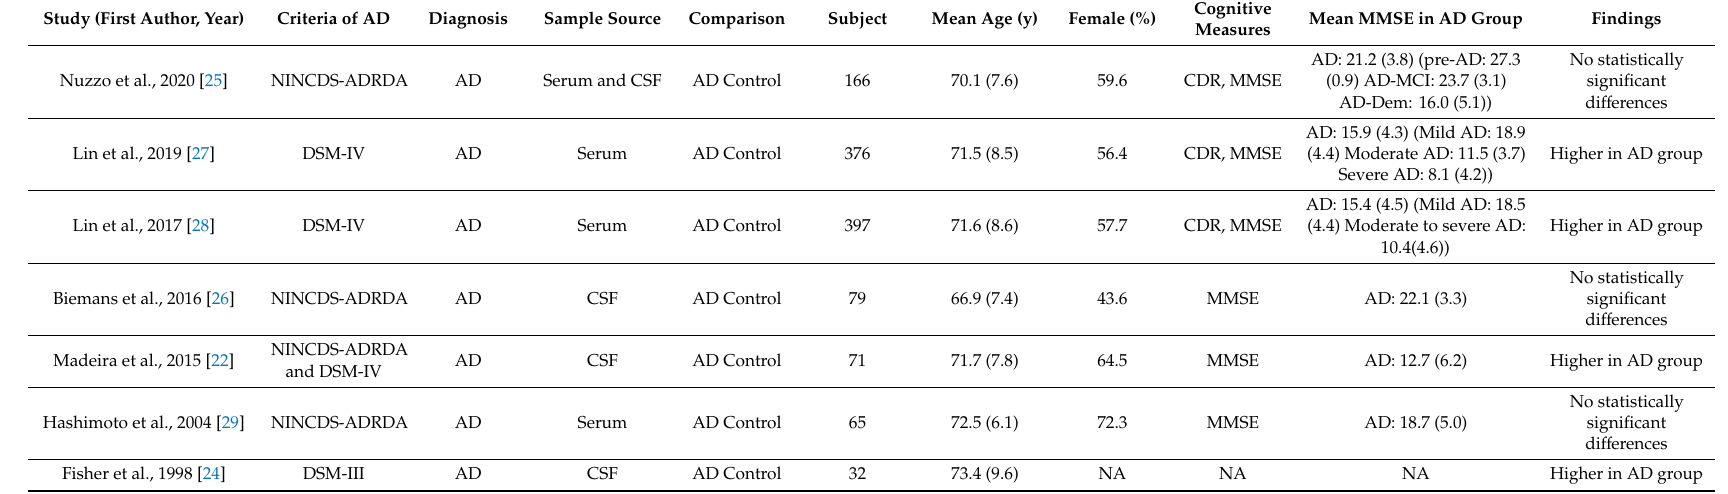
Table 1. Summary of characteristics of studies in current